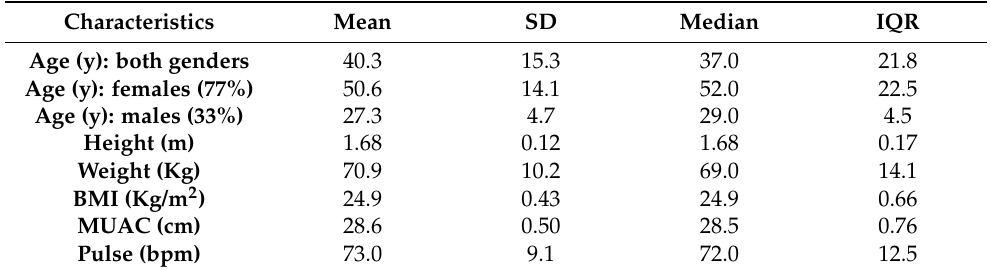
Table 2. Clinical database patients baseline demographics for included cases in this study (N = 18).